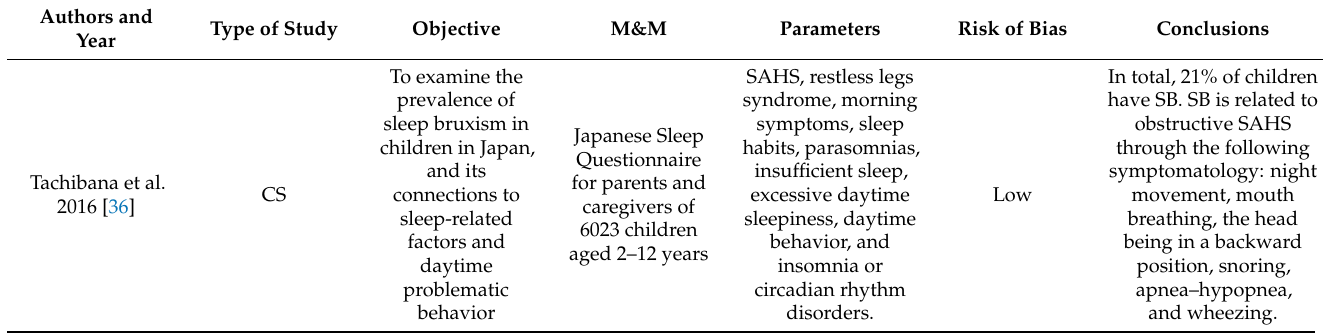
Table 3. Clinical research into the signs and symptoms associated with SB and